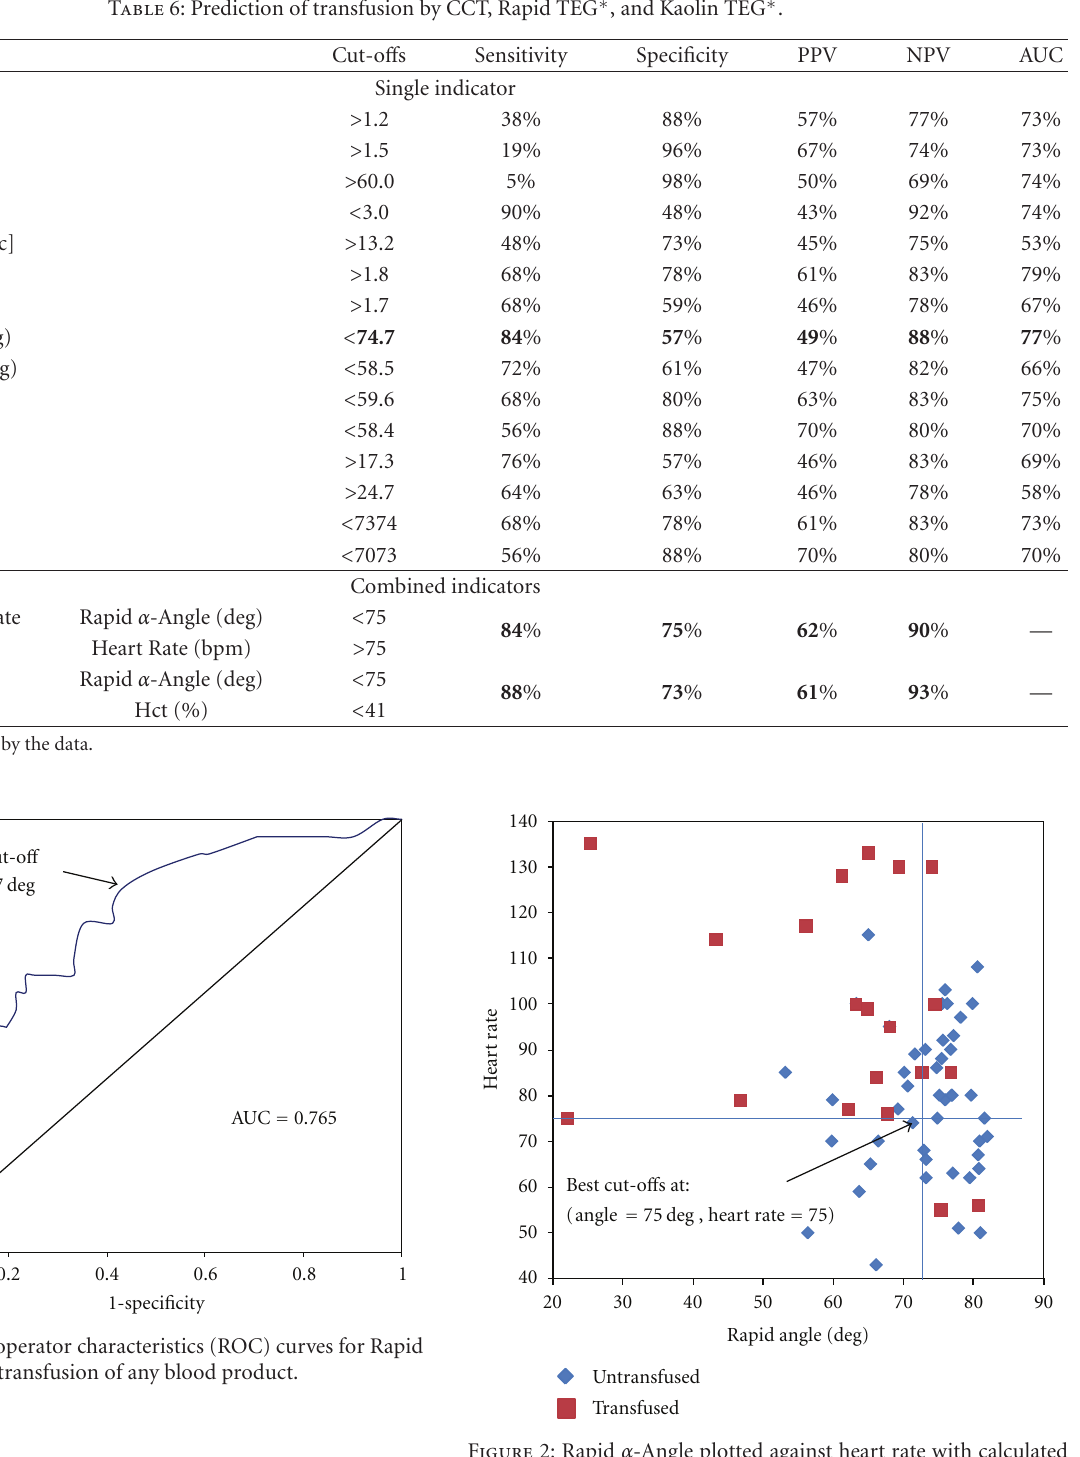
Table 6: Prediction of transfusion by CCT, Rapid TEG ∗ , and Kaolin TEG ∗ .